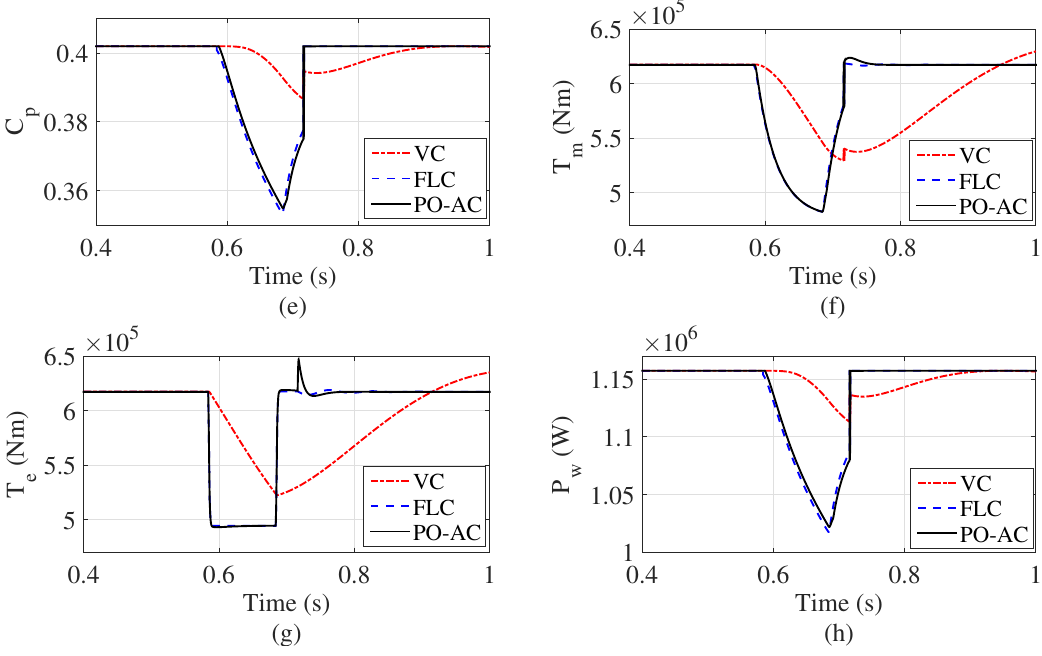
Figure 12. Responses of the WT to constant wind speed with protection under grid voltage dips. ( a ) Wind speed V. ( b ) Grid Voltage E gd . ( c ) Mechanical rotation speed ω m . ( d ) Pitch angle reference β r . ( e ) Power coefficient C p . ( f ) Mechanical rotation torque T m . ( g ) Electromagnetic torque T e